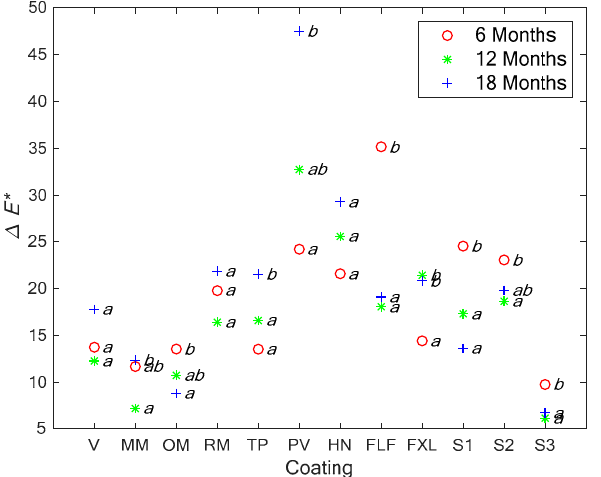
Figure 7. Games–Howell pairwise mean differences of color change for acetylated wood for each coating during the study. Superscripts indicate means between intervals that are not significantly different at the p < 0.05 level.